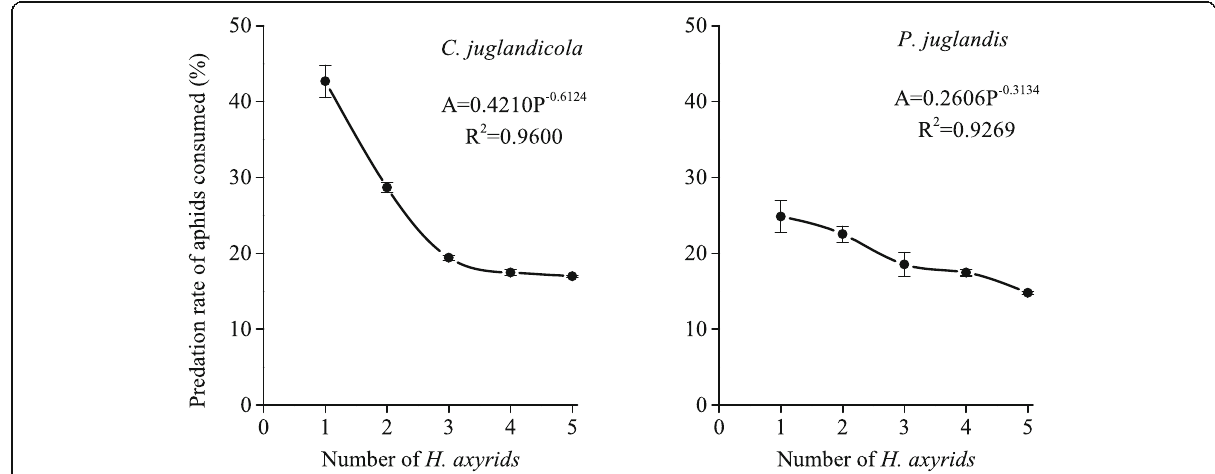
Fig. 3 Watt equation fitted curve of adult H. axyridis predation on C. juglandicola and P.